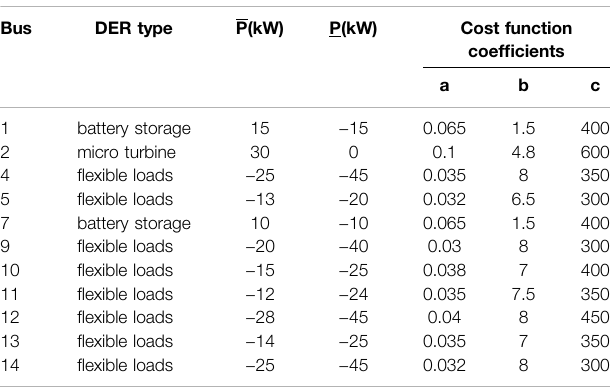
TABLE 5 | Parameters in the